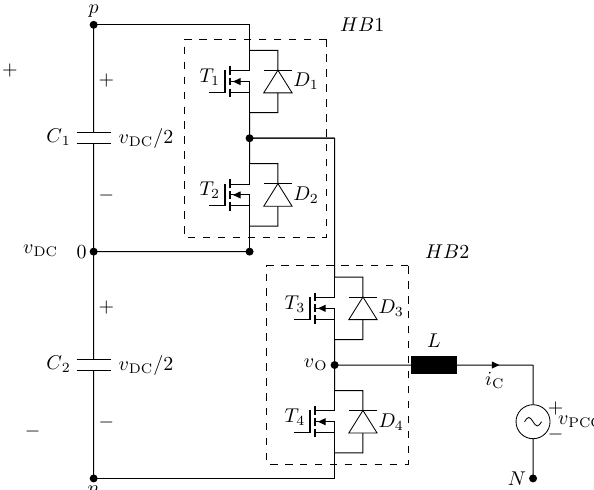
Figure 4. Configuration of the proposed 3L asymmetrical topology (just one leg of the three phase converter is shown). One leg is formed by employing four controlled switches using a cascade connection of two single-phase half-bridges (HB)